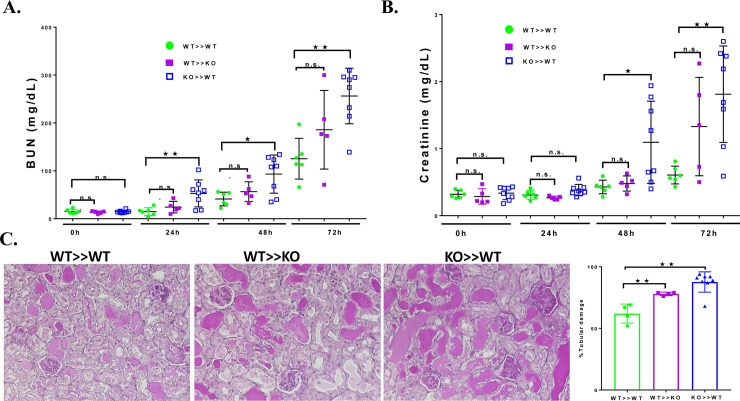
Cisplatin effect on kidney function and structure in chimeric mice.BUN (A) and creatinine (B) were measured before and at 24-hour intervals after injection of cisplatin in WT>>WT (n = 6), WT>>KO (n = 5) and KO>>WT (n = 8). C. PAS-stained sections of kidney 72 hours after cisplatin injection. D. Summary of the tubular damage score for each group of chimeric mice. Statistical analysis: WT>>WT was compared with WT>>KO and KO>>WT for each time point using one-way ANOVA with Tukey's post hoc analysis; Mean ± SEM. *p < 0.05, **p < 0.01, ns, not-significant.